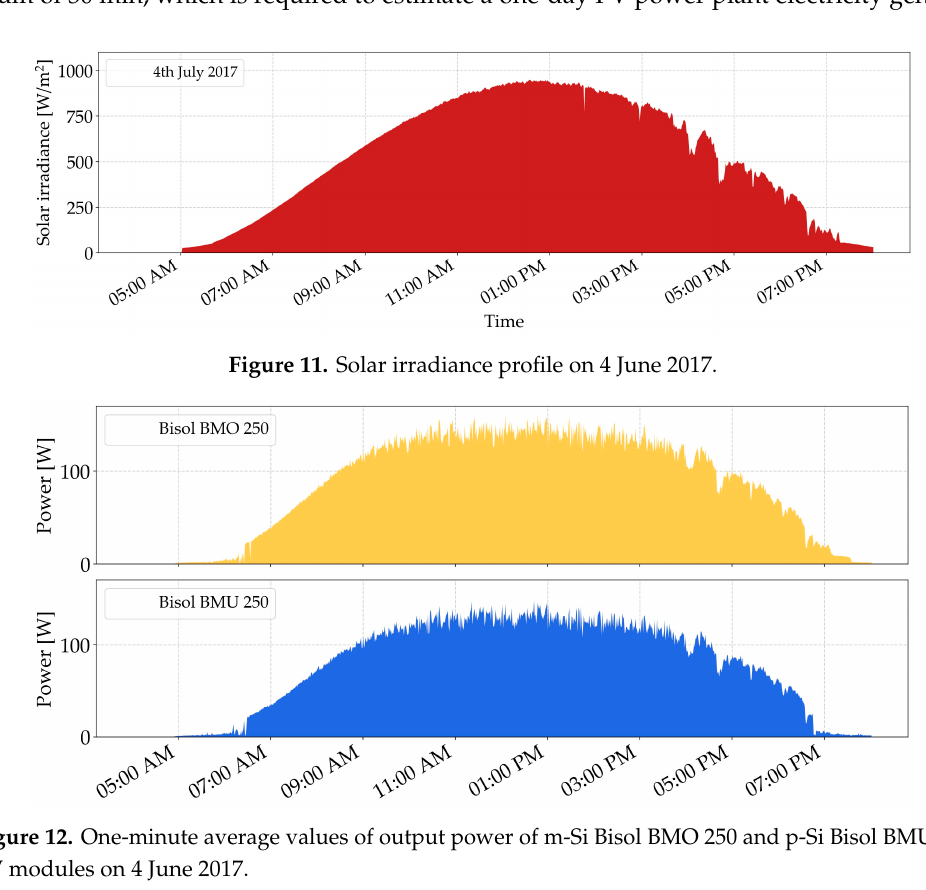
Table 8. PV plant configurations for the 12 kW PV plant. Table 9. Results of fast PV power emulation of the 12 kW PV plant for 4 June m-Si Bisol BMU 250